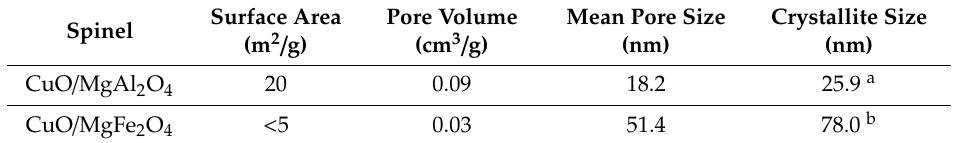
Table 1. Structural properties of CuO / MgAl 2 O 4 and CuO / MgFe 2 O 4 nanocatalysts.